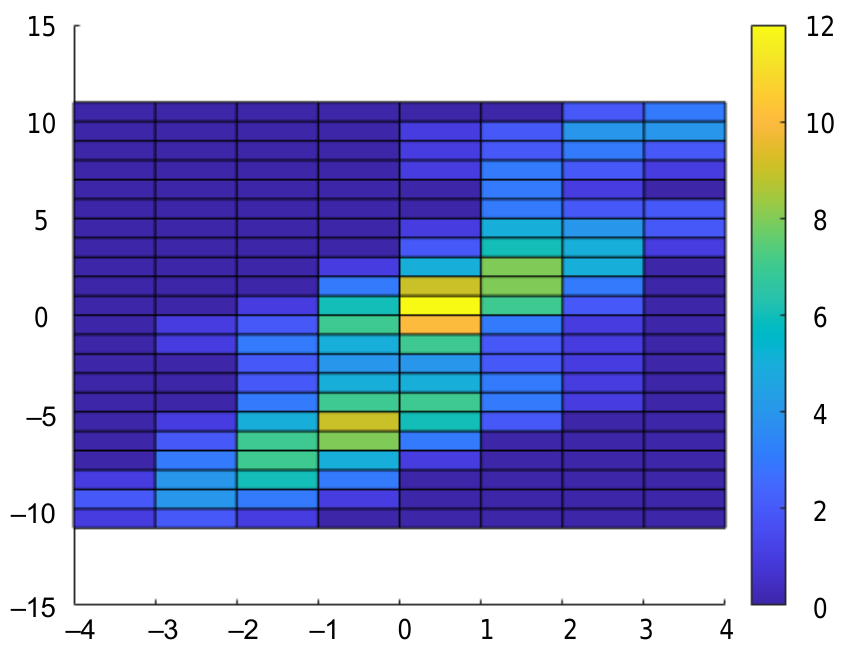
Figure 23. Surface plot of the bi-dimensional cross-correlation of the gait map from Table 5 to the physiological gait map template from Table 4.